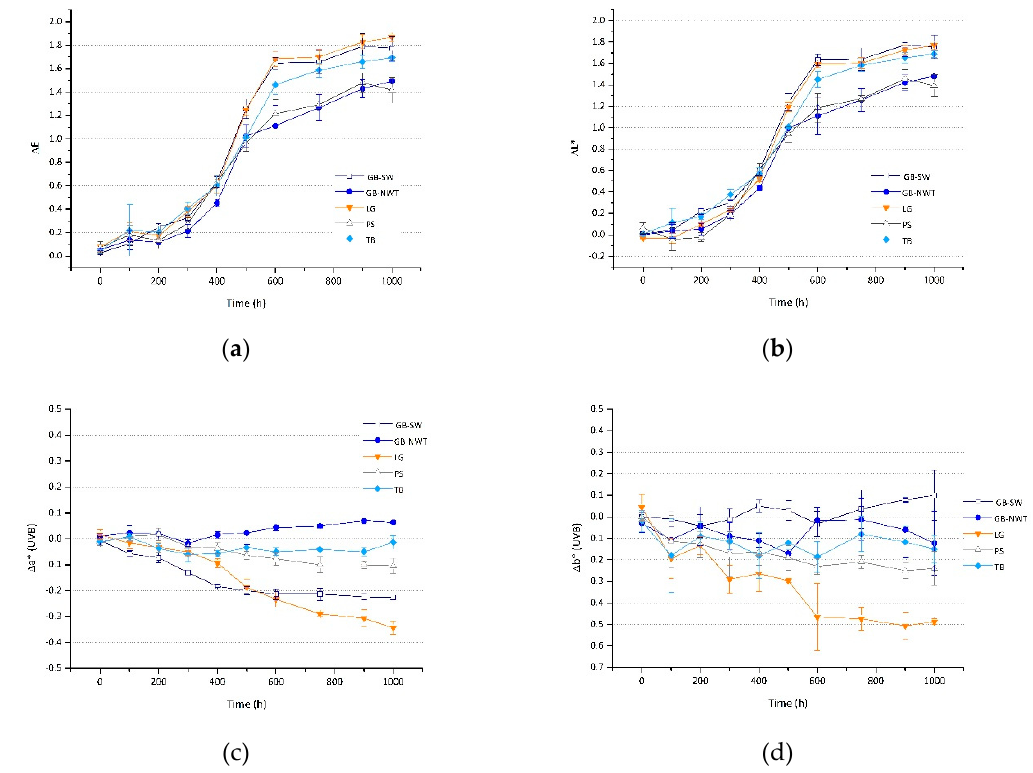
Figure 5. Colorimetric coordinates variation after UVB light exposure: ( a ) Δ E ; ( b ) Δ L *; ( c ) Δ a *; and ( d )